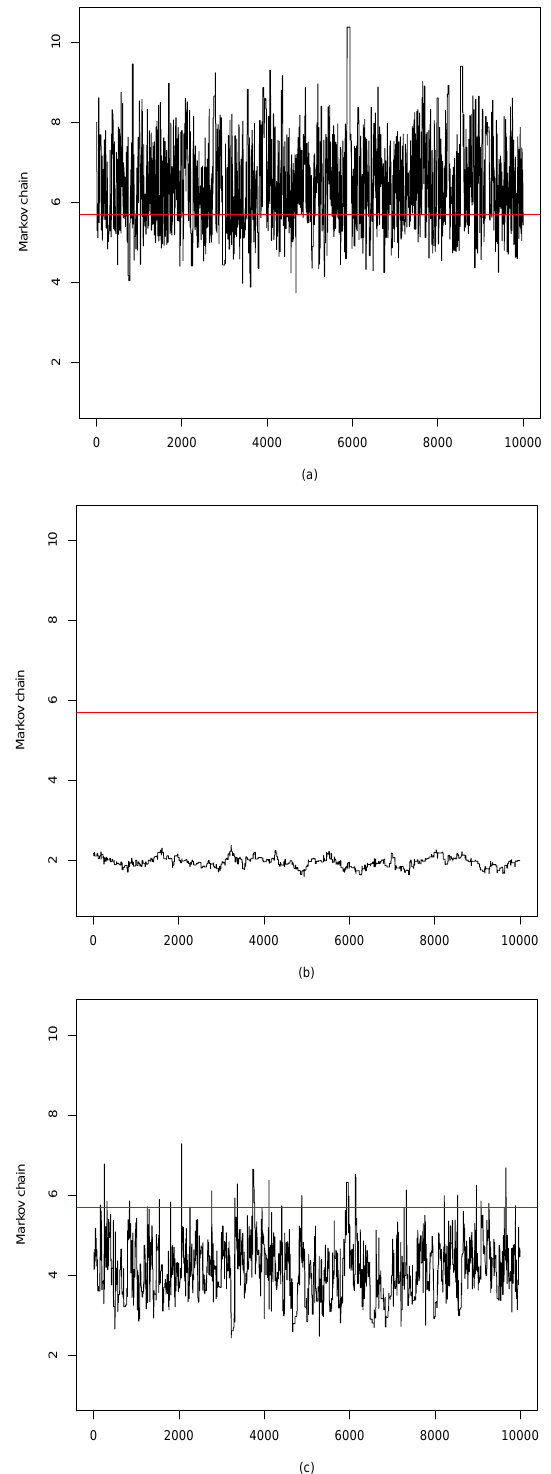
Figure 8. The Markov chain of ˜ a 0 via using ( a ) domain I, ( b ) domain II, and ( c ) domain III: The straight line is the true value of a 0